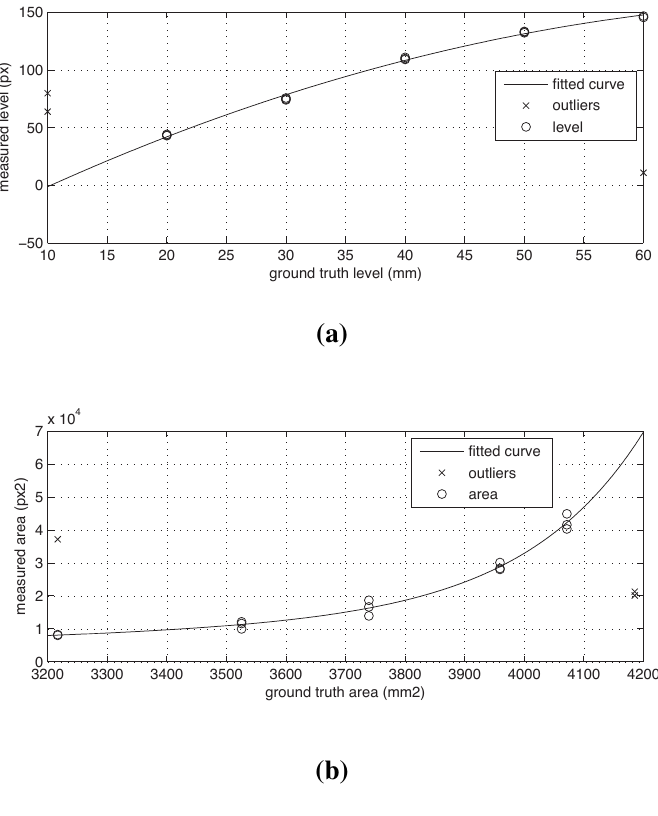
Figure 7. ( a ) Liquid level data plot; ( b ) Liquid surface area data